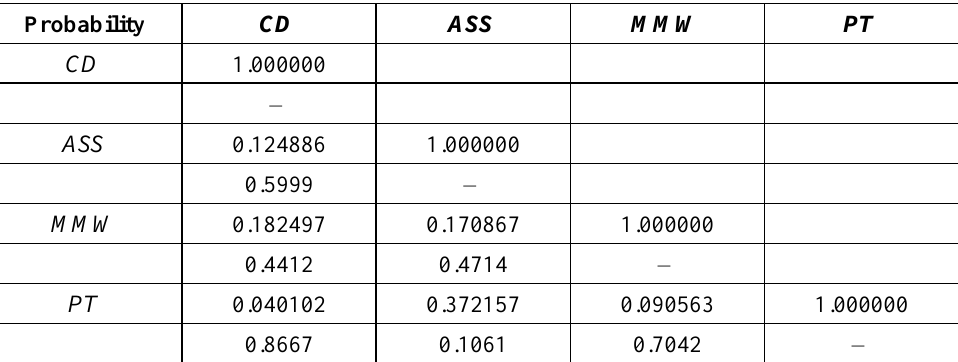
Table 3. Correlation (authors’ computation,